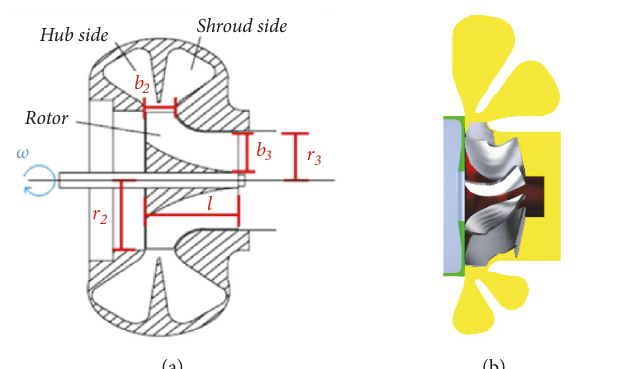
Figure 1: (a)Sketchof meridional section of a generictwin scroll turbine; (b)rotor view with a cutof the volute and housing with the backside cavity (in green).